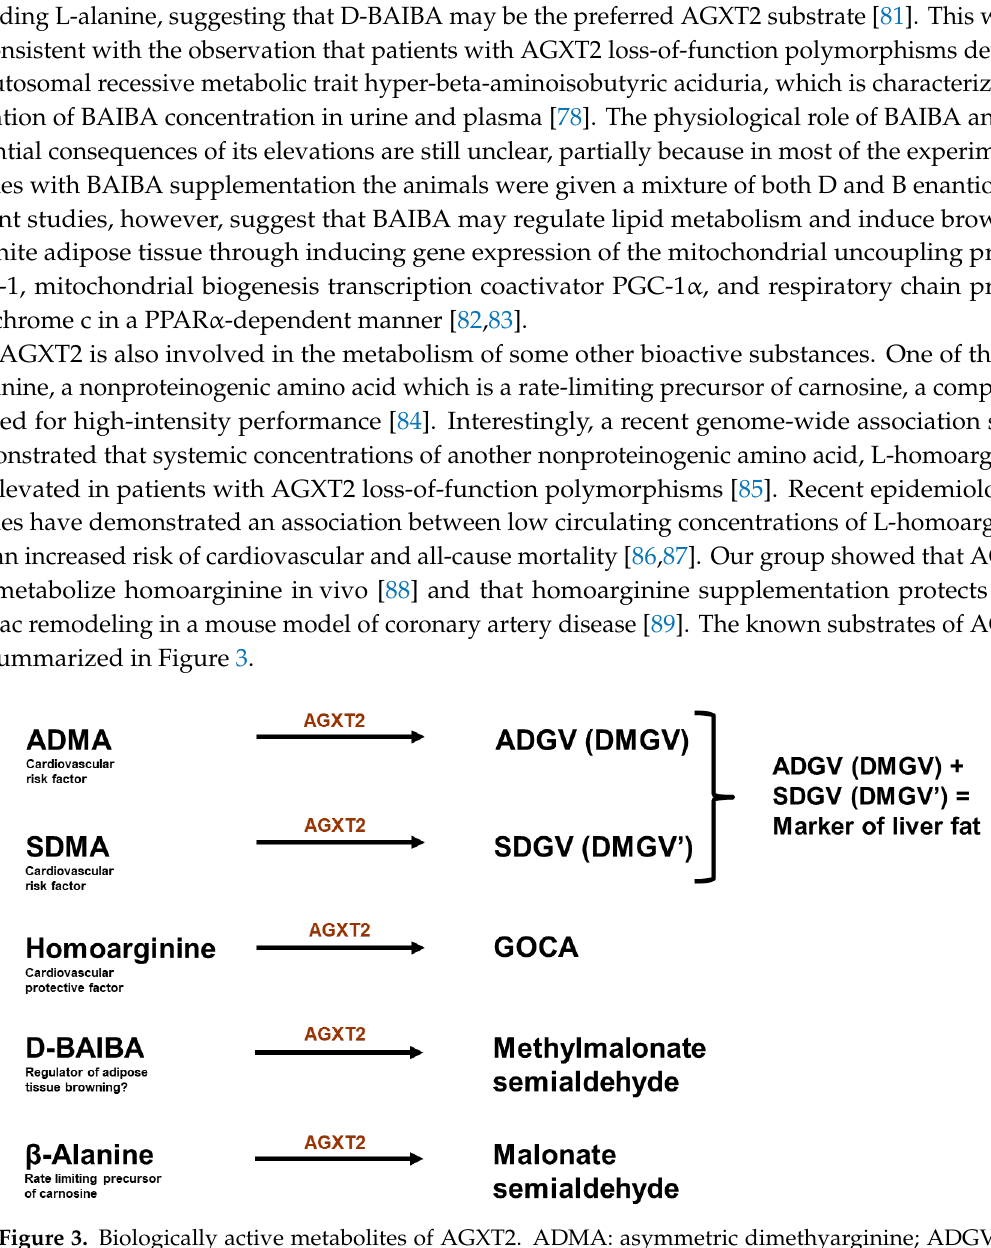
Figure 3. Biologically active metabolites of AGXT2. ADMA: asymmetric dimethyarginine; ADGV: asymmetric α-keto-dimethylguanidinovaleric acid; SDMA: symmetric dimethylarginine; SDGV: symmetric α-keto-dimethylguanidinovaleric acid; GOCA: 6-guanidino-2-oxocaproic acid; BAIBA: beta-aminoisobutyric acid. Alanine and glyoxylate (another substrates of AGXT2) are intentionally not included in the figure, as it is not clear whether AGXT2 plays a biologically significant role in regulation of their levels.